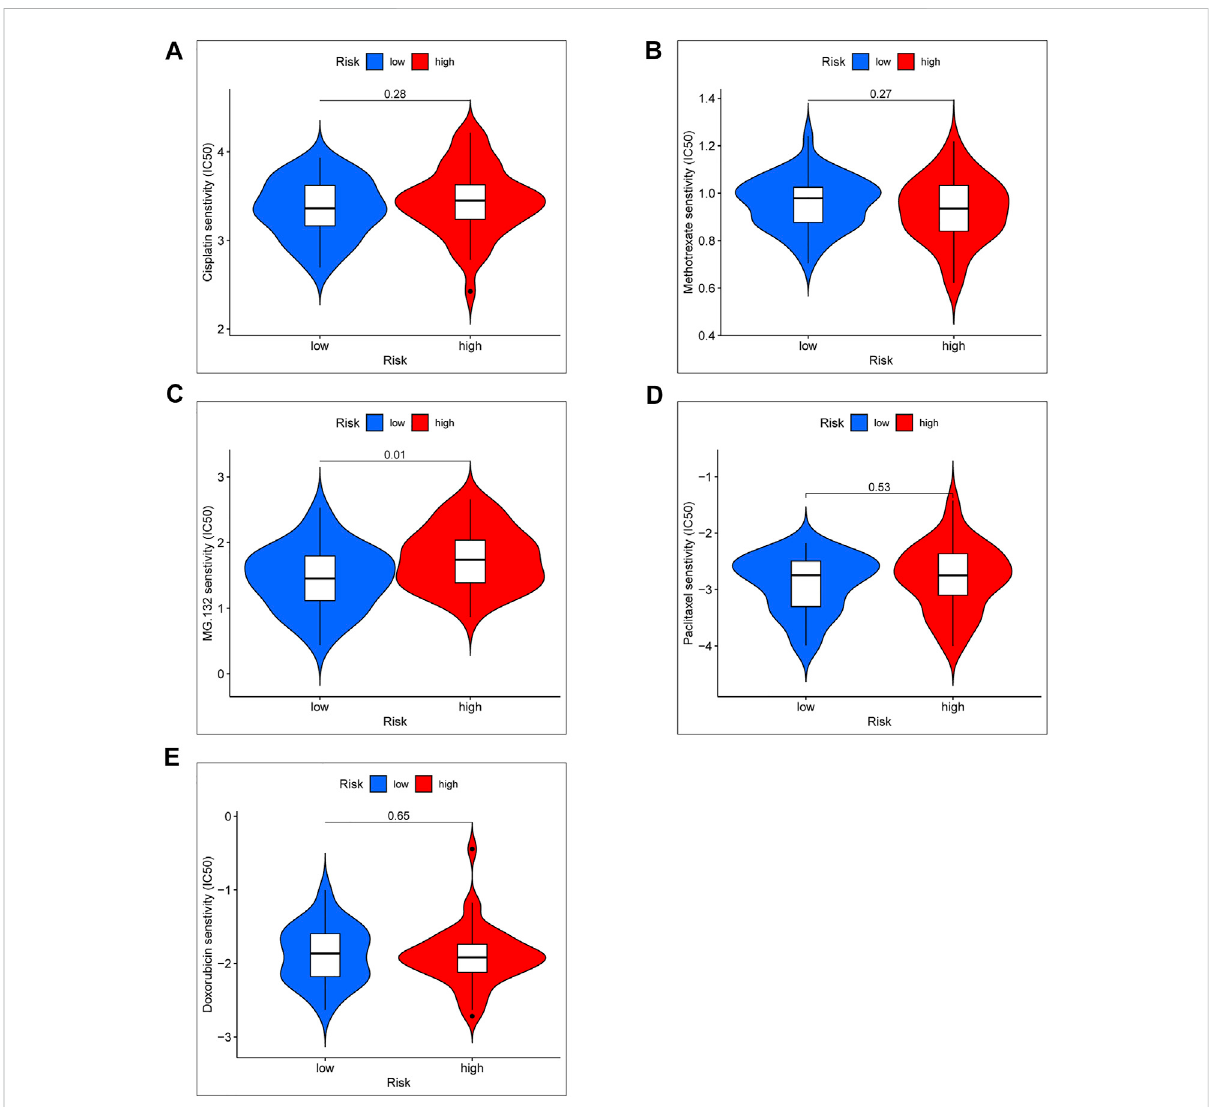
FIGURE 8 Chemotherapy drug sensitivity between the high- and low-risk group. (A) IC50 of Cisplatin. (B) IC50 of Methotrexate. (C) IC50 of MG-132. (D) IC50 of Paclitaxel. (E) IC50 of Doxorubicin.